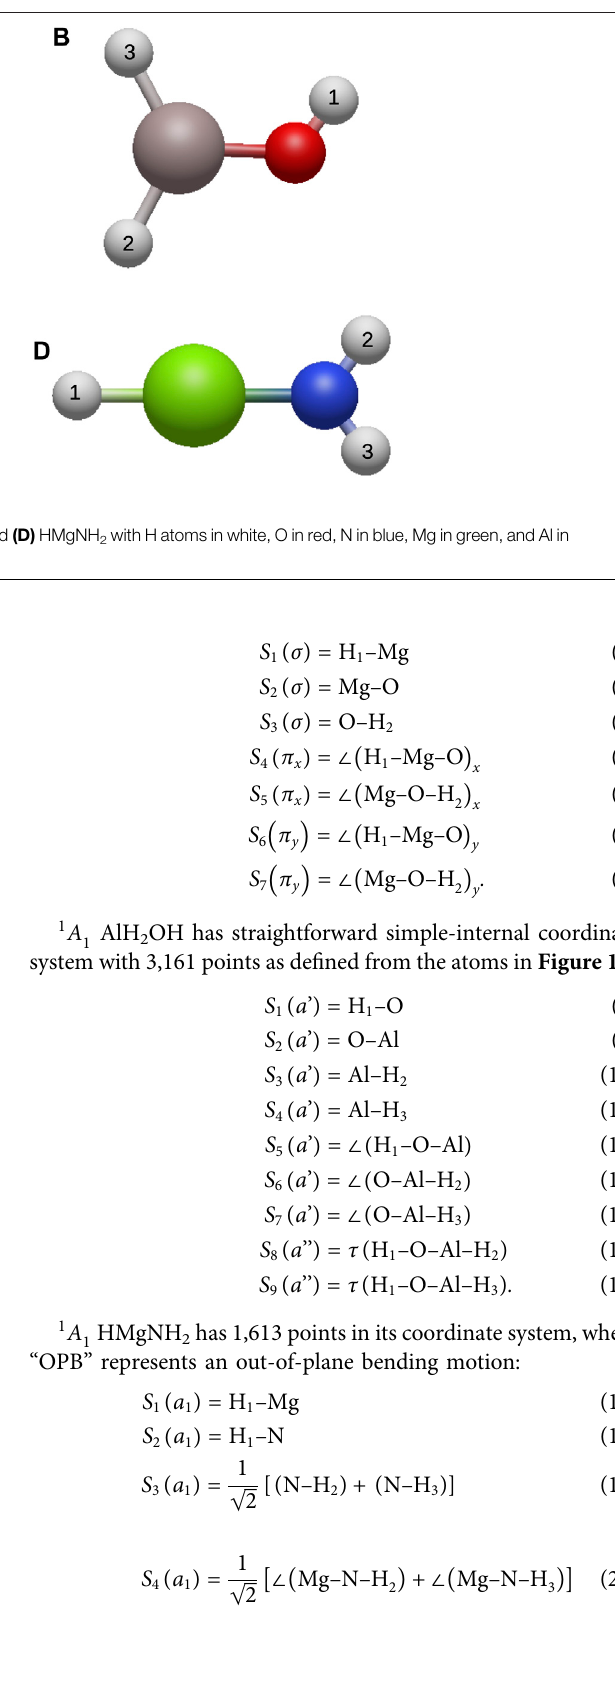
Frontiers in Astronomy and Space Sciences |